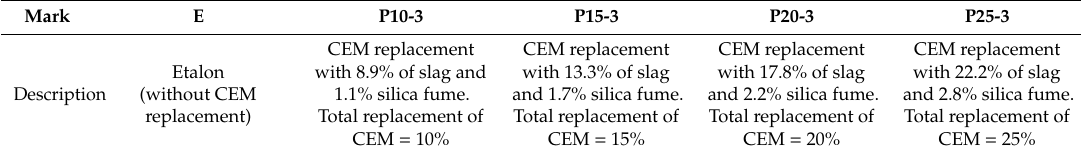
Table 10. Preparation of the mixtures with the additions of the di ff erent amounts of the silicate fume. Mark E P10-3